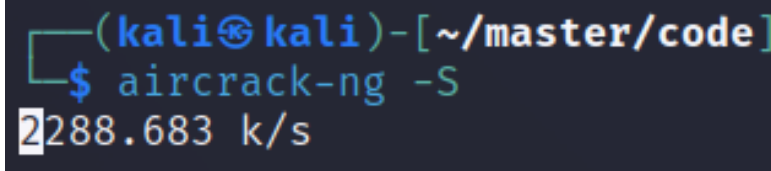
Figure 22. Aircrack-ng password cracking speed on Kali Linux machine.